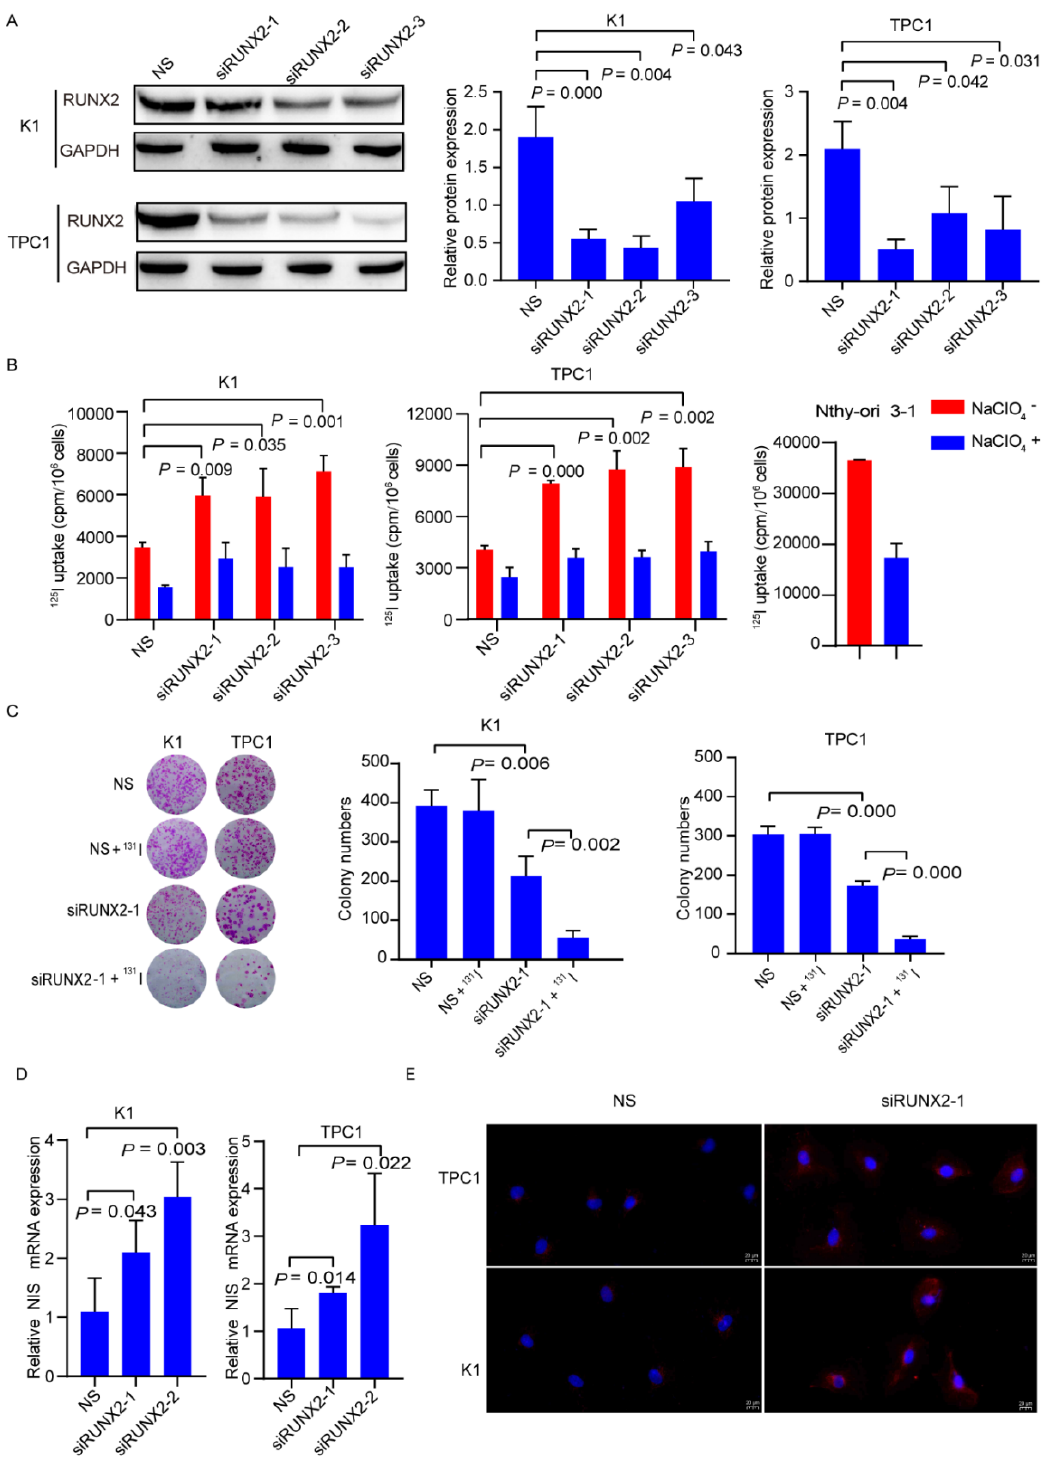
Figure 5. Targeting RUNX2 enhances differentiation of RR-PTC cells. ( A ) Successful transfection with siRUNX2-1, siRUNX2-2, and siRUNX2-3 demonstrated by Western blot. ( B ) 125 I uptake in K1 and TPC1 cells with or without transfection with siRUNX2-1, siRUNX2-2, and siRUNX2-3. ( C ) 131 I clonogenic assay in K1 and TPC1 cells with or without transfection with or without siRUNX2-1. ( D ) NIS mRNA expression in K1 and TPC1 cells with or without transfection with siRUNX2-1 and siRUNX2-2. ( E ) NIS membrane localization in K1 and TPC1 cells with or without transfection with siRUNX2-1. Scale bar: 20 µ